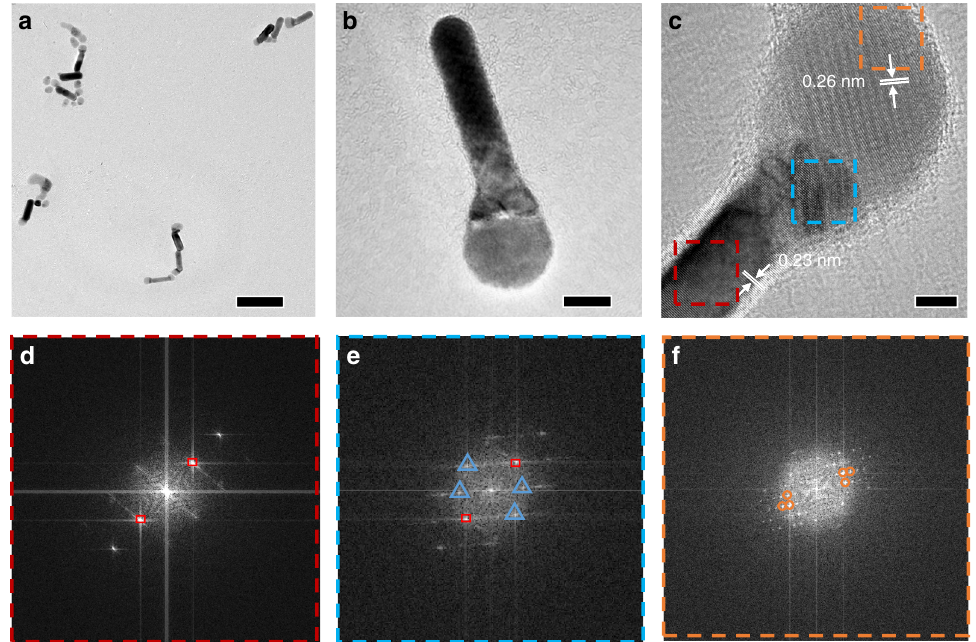
Fig. 4 Formation of Au – Ag 2 S matchstick-like HNPs through welding of Au NRs and spherical Ag 2 S NPs. a – c TEM images of HNPs obtained by welding Au NRs and Ag 2 S NPs at different magni fi cations. d – f Corresponding FFT pattern of different regions in c : Au region in red box ( d ), welding region in blue box ( e ), and Ag 2 S region in orange box ( f ).The red squares, orange circles, and blue triangles in d – f highlighted the FFT patterns of Au, Ag 2 S, and a new phase, respectively. Scale bars are 100 nm in a , 10 nm in b , and 5 nm in